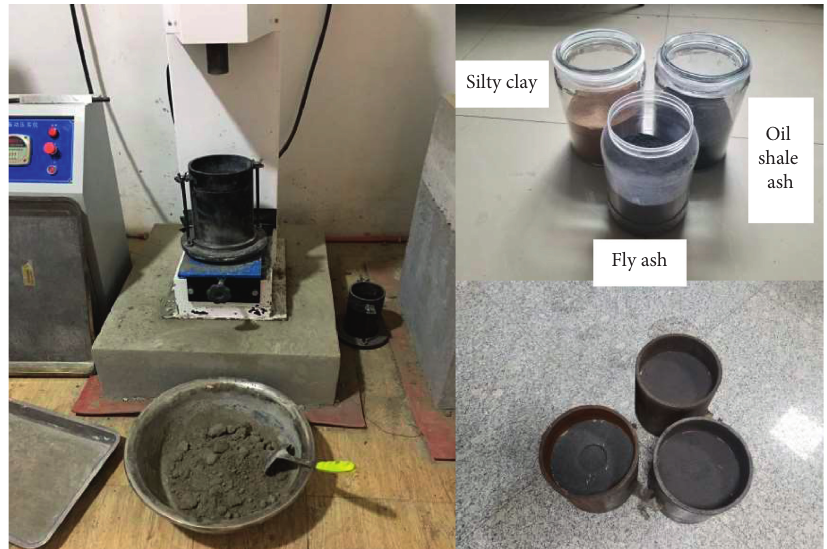
Figure 2: Preparation of test